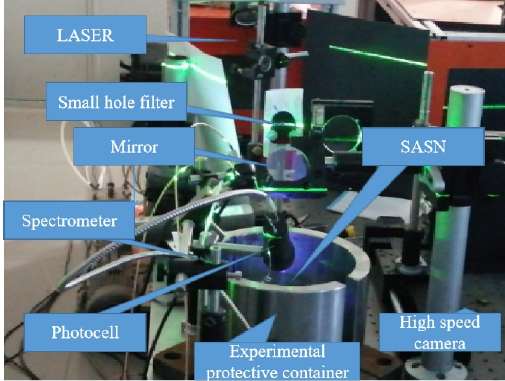
Figure 3. Different laser initiation platform systems.